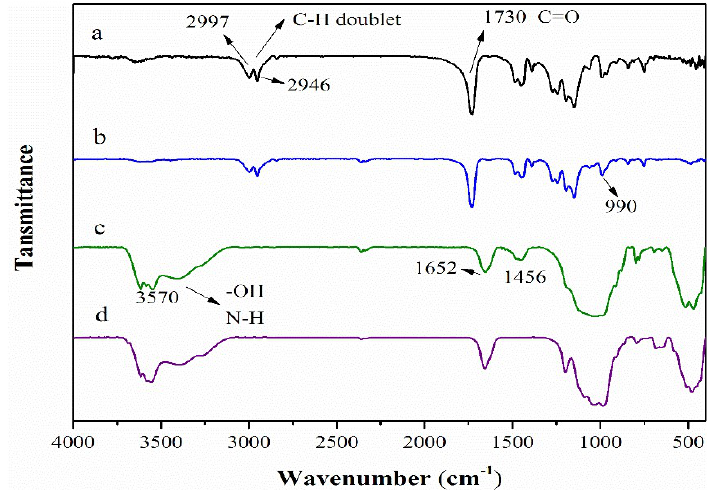
Figure 2. FTIR spectra of PMMA, poly(OPal-MMA), OPal, and Pal. ( a ) PMMA; ( b ) poly(OPal-MMA); ( c ) OPal; ( d ) Pal.